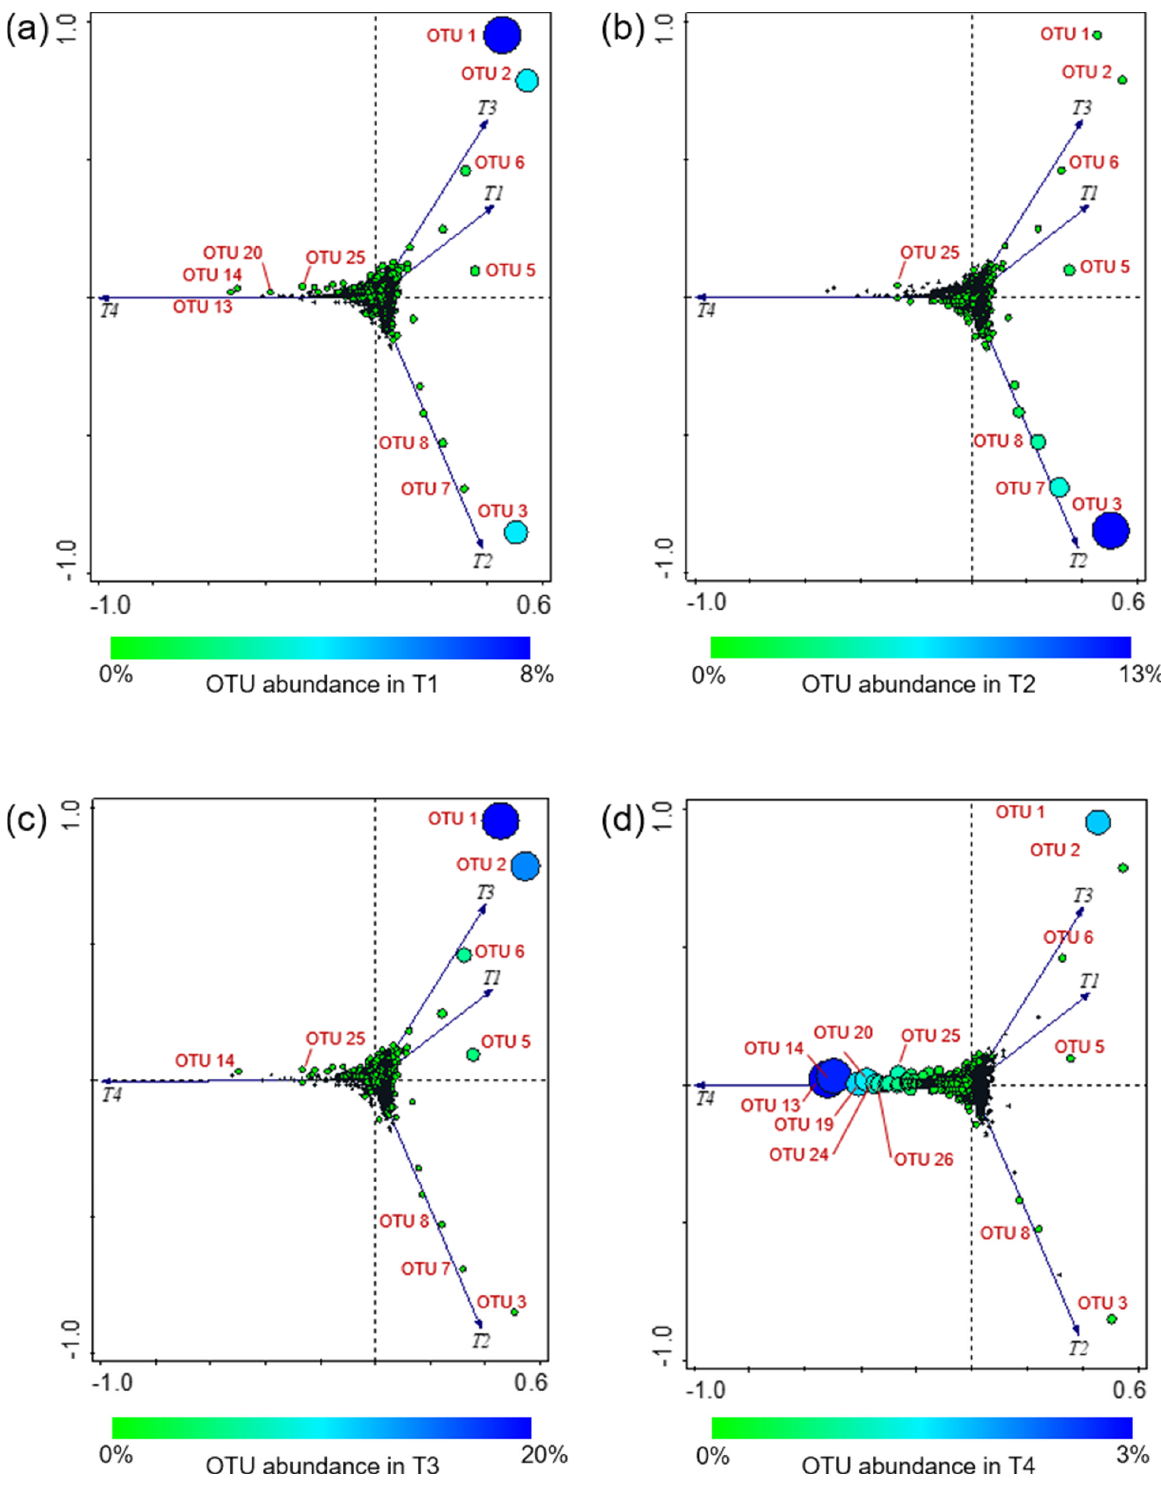
Figure 7. Principal component analysis (PCA) based on the bacterial OTU found across the investigated experimental conditions. Four plot visualizations of the same PCA analysis are provided to better show the OTU occurrence in the four experimental conditions; OTU abundance variation in T1 ( a ), T2 ( b ), T3 ( c ), and T4 ( d ). Circle size is proportional to the OTU relative abundance in the samples; OTU absence in an experimental condition is indicated by “+”. T1: WT/OF, T2: WT/CF, T3: SB/OF, T4: SB/CF.